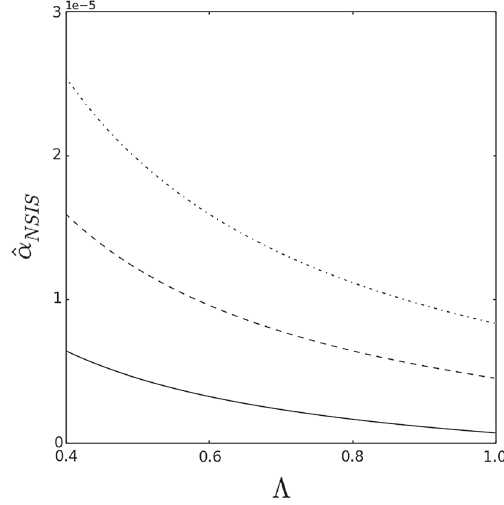
Fig. 9 Plot of ˆ α NSIS vs. Λ for (cid:22) J r = 0 . 1 (continuous line), (cid:22) J r = 0 . 2 (dashed line), and (cid:22) J = 0 . 3 (dot-dashed line). We used, b = 100, r c = 10, sin χ = 1, and ω 2 c /ω 2 = 0 . 5. Note the scale used for the deflection angle: each value is multiplied by 1 e − 5 = 1 × 10 − 5